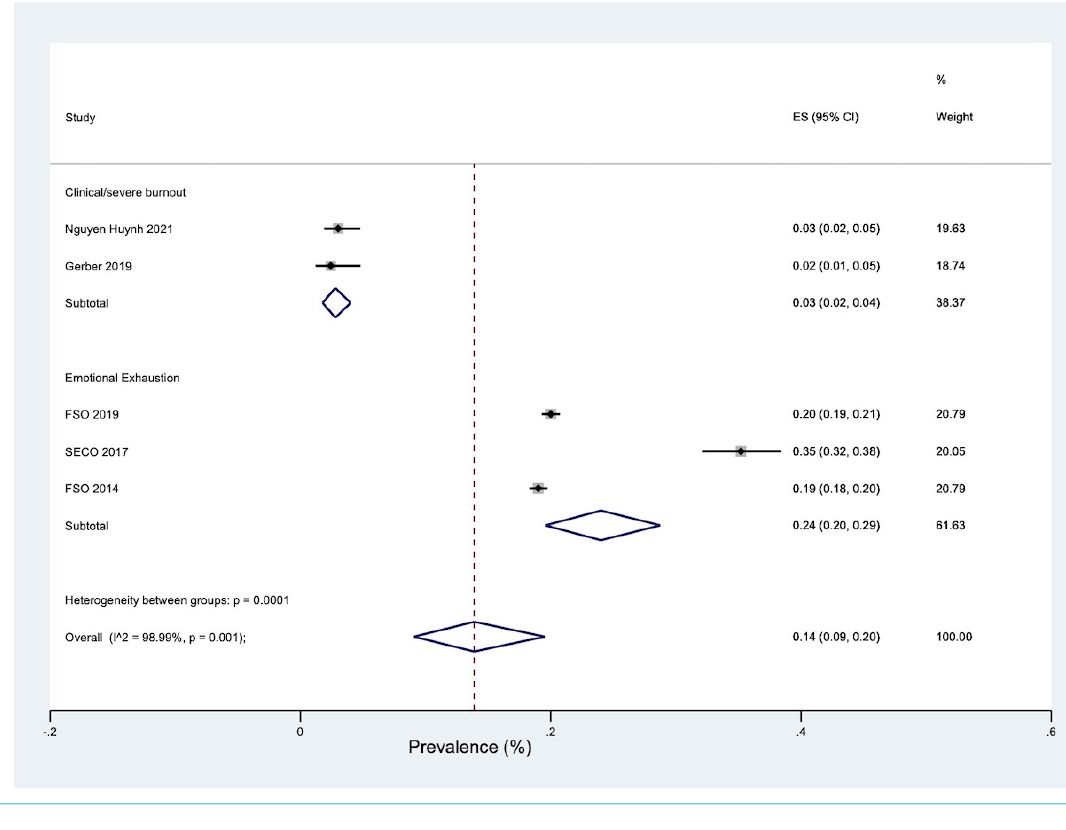
Figure 4: Prevalence of burnout in the general working population.